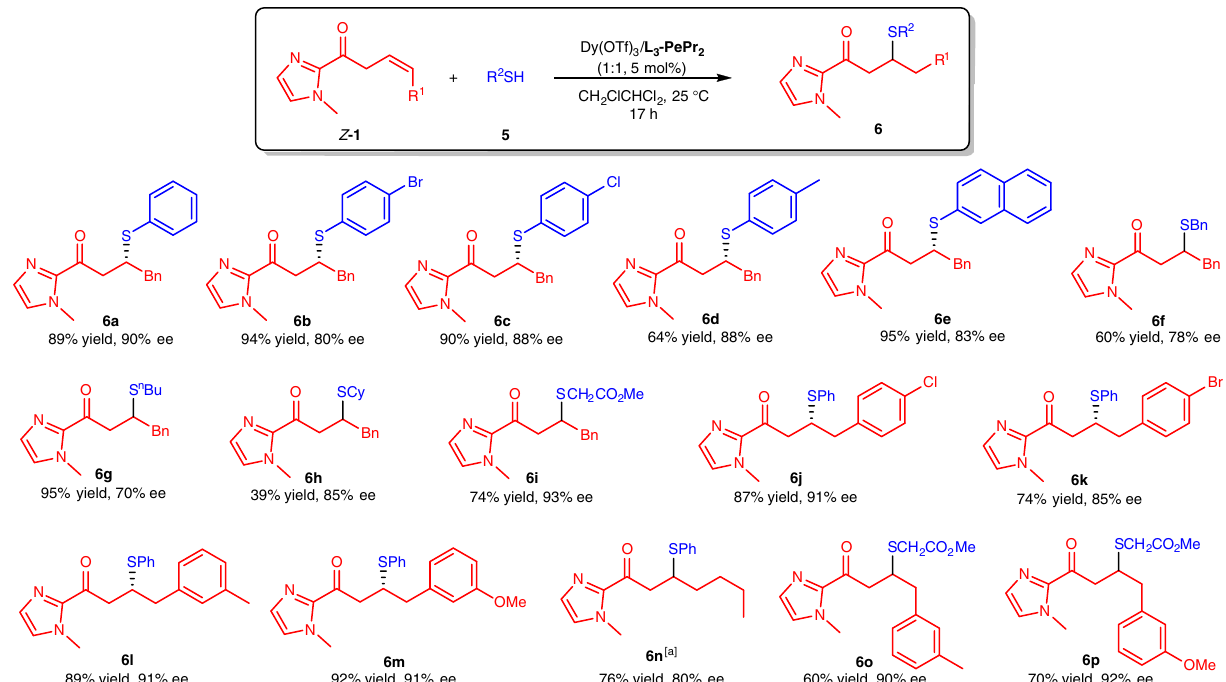
Fig. 5 Substrate scope in isomerization/sulfur-Michael reaction. Unless otherwise noted, all reactions were performed with Dy(OTf) 3 / L 3 -PePr 3 (1:1, 5 mol%), 1 (0.25 mmol), 5 (0.10 mmol) in CH 2 ClCHCl 2 (1.0 mL) at 25 °C for 17 h. [a] Z / E mixture of β , γ -unsaturated 2-acyl imidazole was used for 6n . The reaction time was 5 days.